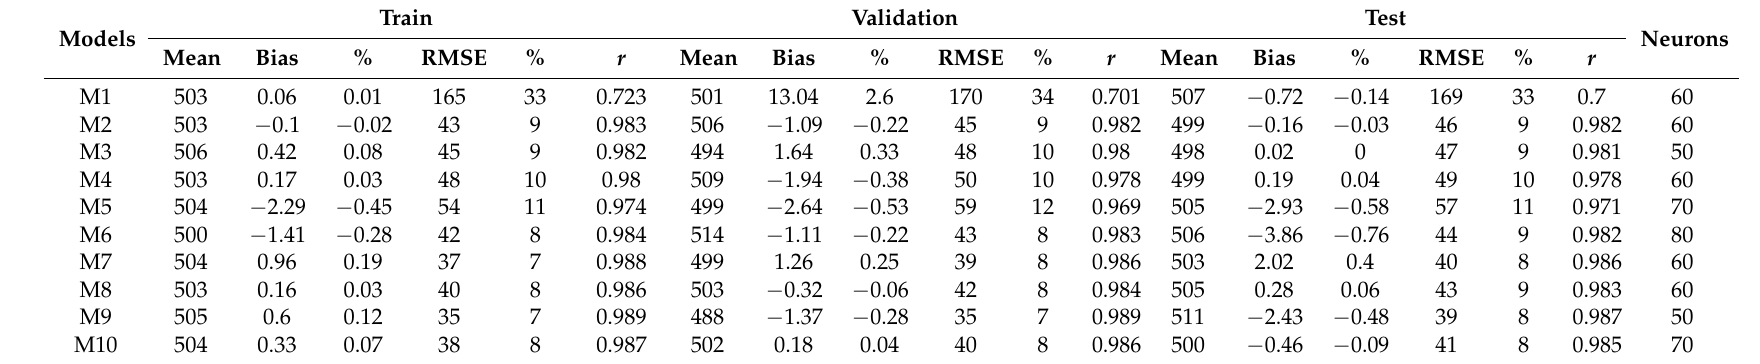
Table A8. As in Table A1, but for Maydan automatic